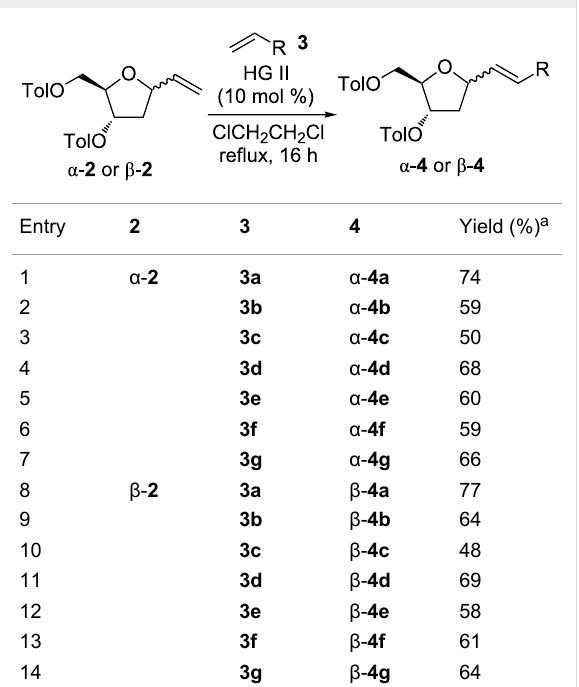
Table 2: Cross-coupling of 2 α and β - 2 with alkenes 3